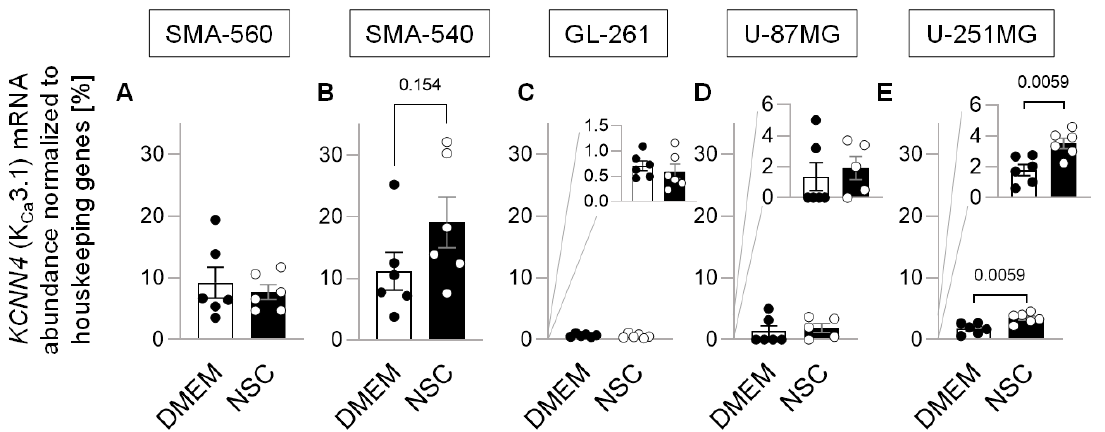
Figure 3. Effect of the enrichment of the glioblastoma stem cell fraction on K Ca 3.1 mRNA abundance.